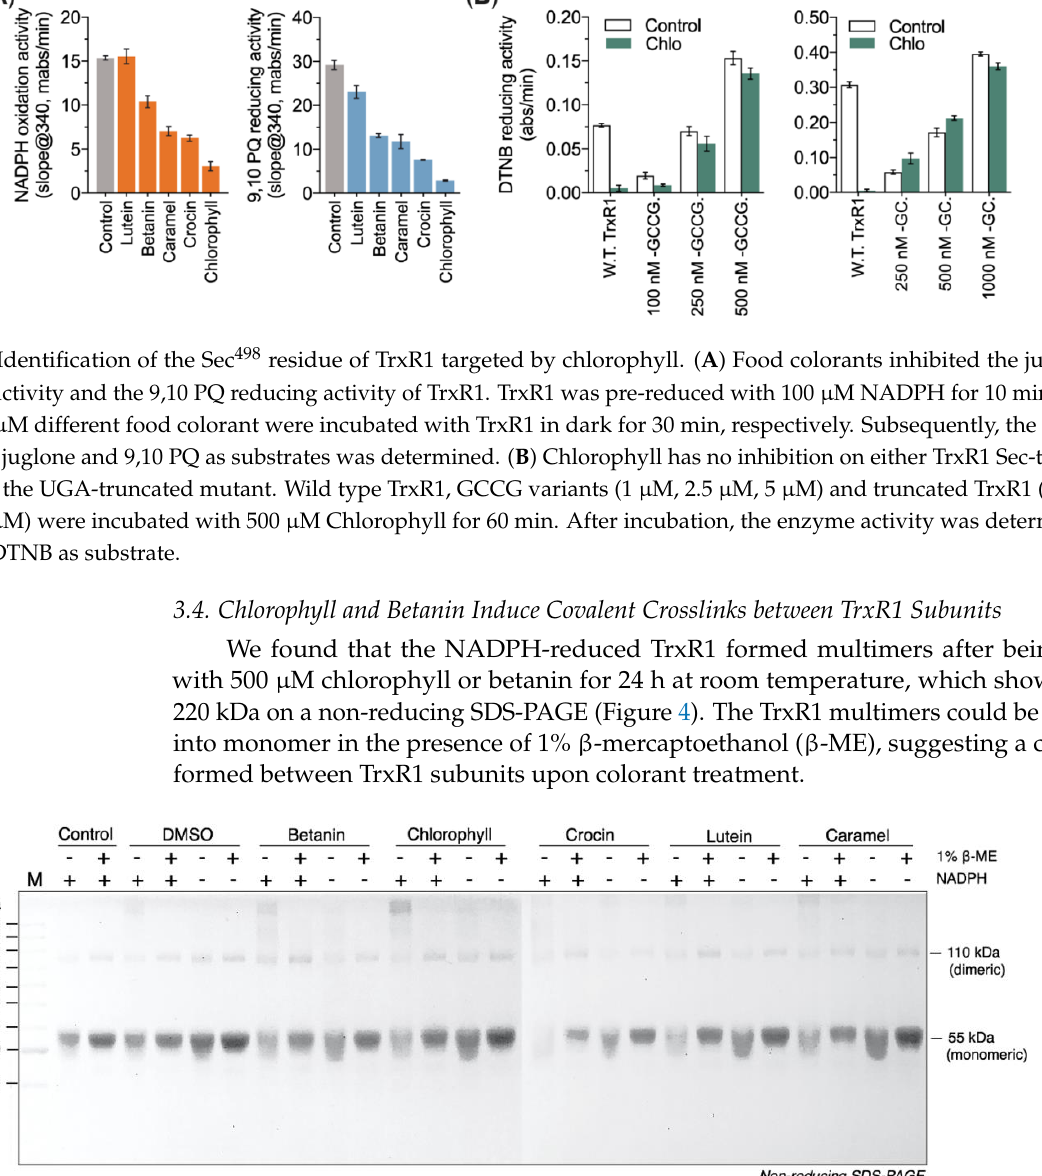
Figure 4. Chlorophyll and betanin trigger the oligomerization on wild type TrxR1 in vitro. Wild type TrxR1 (0.8 µM) was incubated with 500 µM food colorants for 24 h at room temperature in dark with or without 200 µM NADPH. DMSO was used as the control. After incubation, samples were subjected to 10% non-reducing SDS-PAGE, followed by Coomassie Blue staining, and documented using ChampGel TM 5000 Plus gel imaging system (Sage Creation Science Corp., Beijing, China).